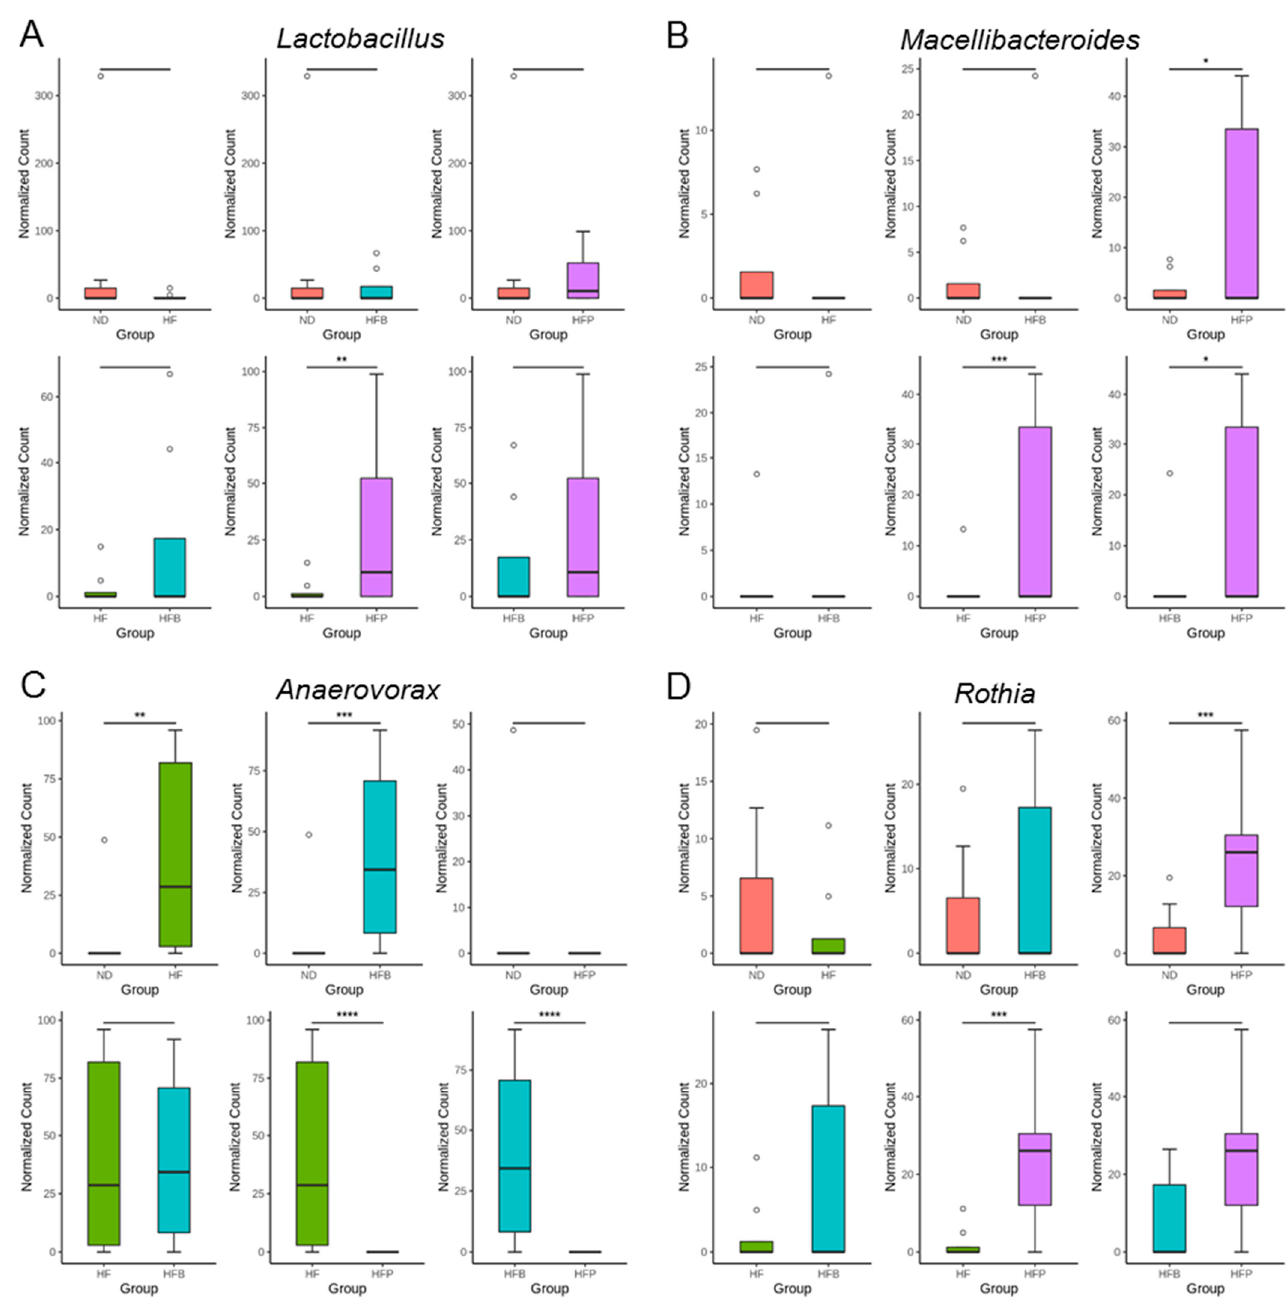
Figure 6. The comparison of genera ( A ) Lactobacillus , ( B ) Macellibacteroides , ( C ) Anaerovorax , and ( D ) Rothia between the ND (orange-red), HF (green), HFB (blue), and HFP (purple). N = 8/group. * p < 0.05; ** p < 0.01; *** p < 0.005; **** p < 0.001.